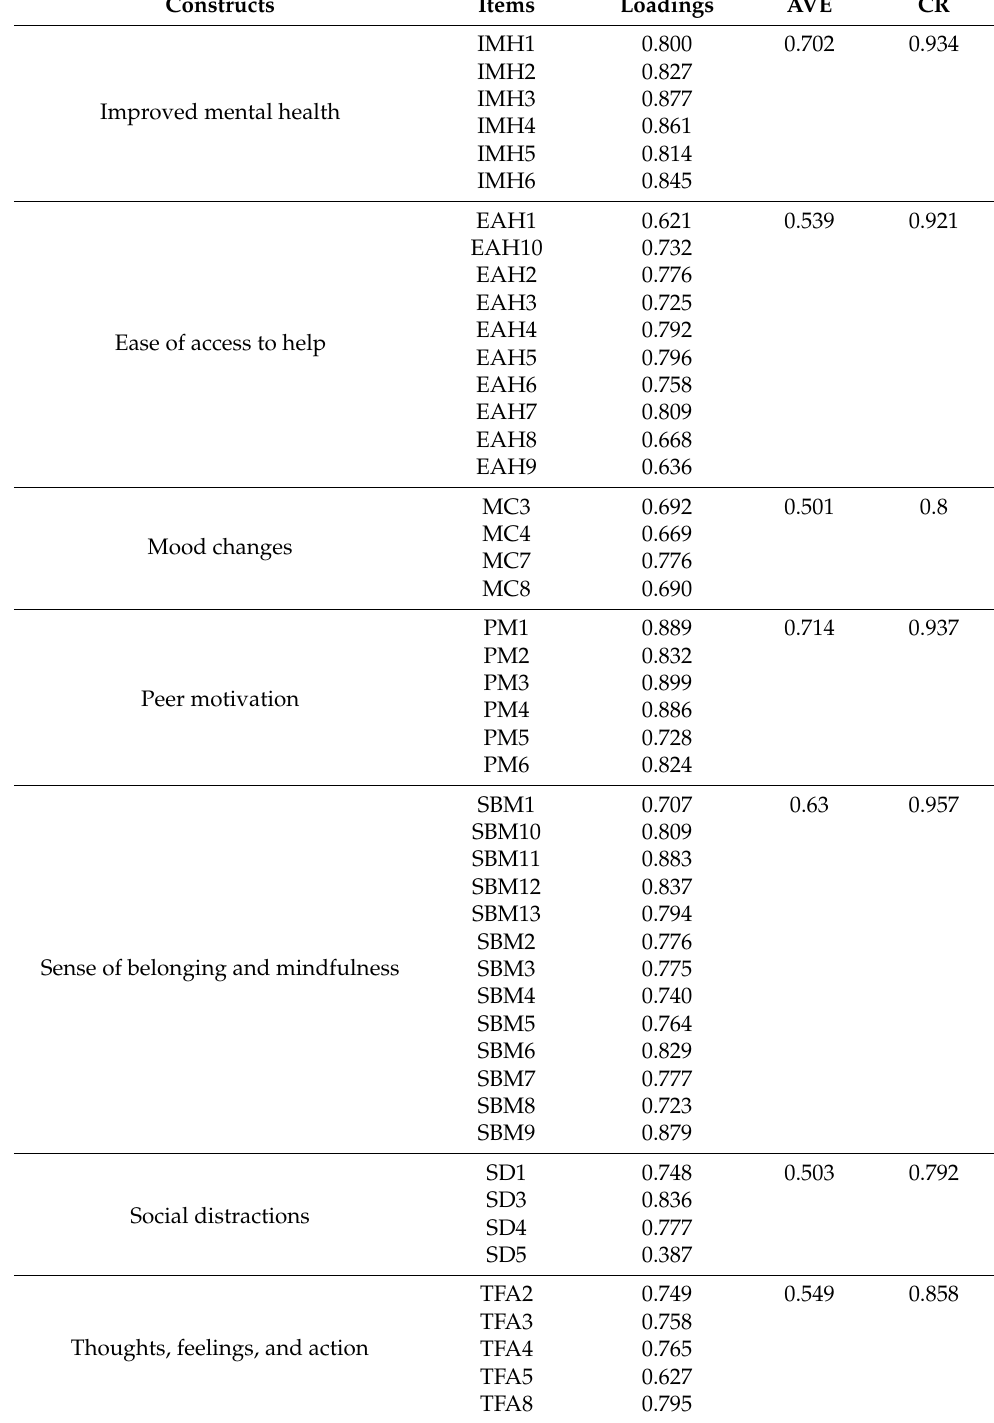
Table 2. Factor loadings, average variance extracted (AVE), and composite reliability for each construct and